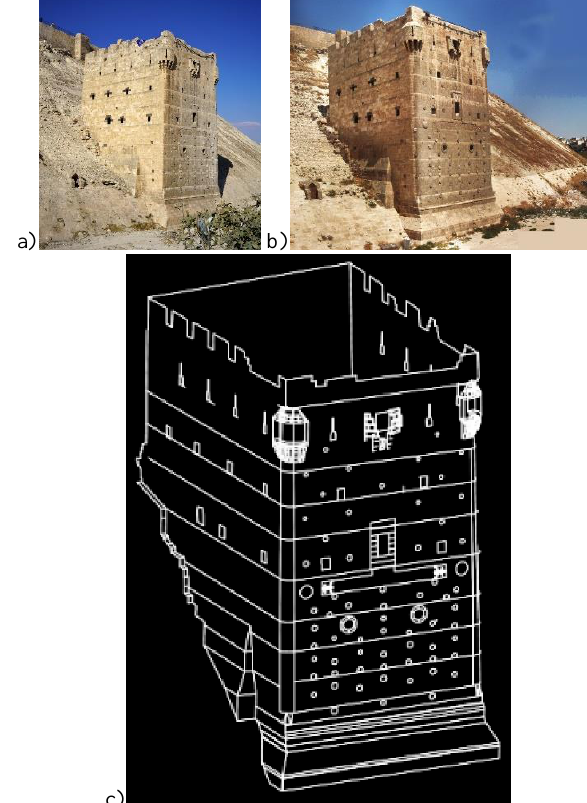
Figure 7. The Southern tower of the Citadel now (a), as it was (b) and a 3D restitution (c), by Oma